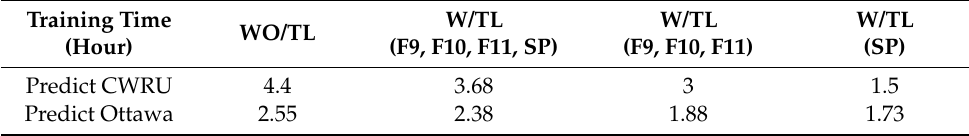
Table 3. Training time measured in hours (Unit: Hour).